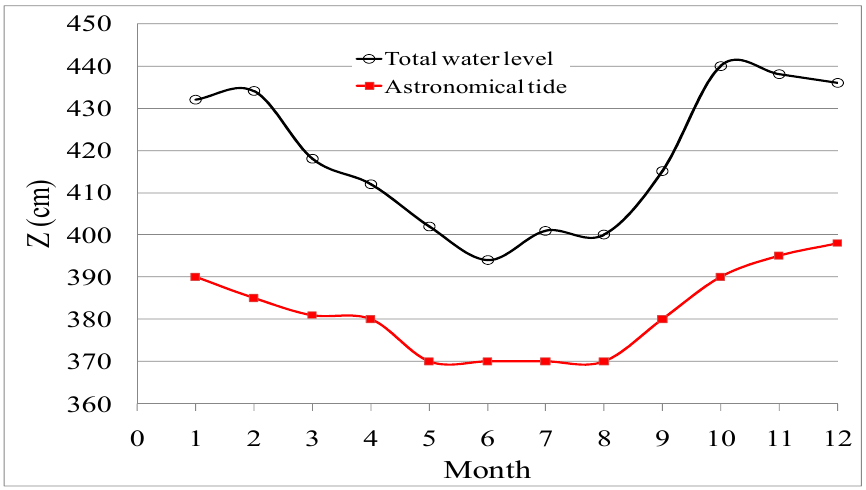
Figure 4. The peak astronomical tide of month in 2016 and maximum observed water level in the period 1987–2016.